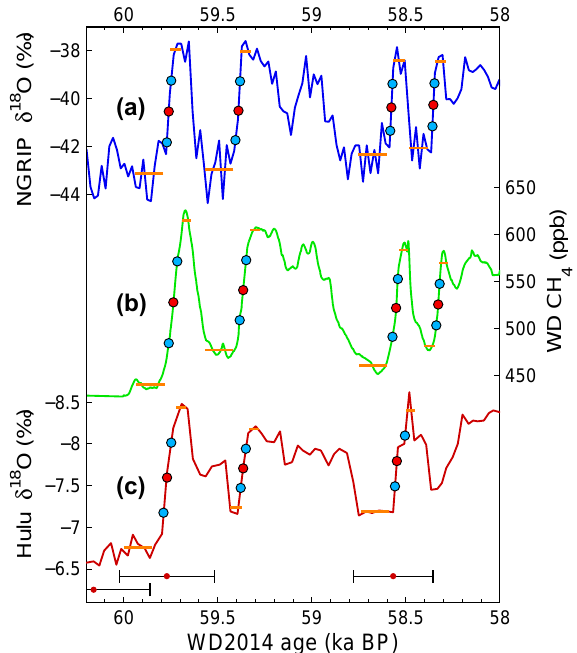
Figure 6. Determining the midpoint for the abrupt warming phases of (from oldest to youngest) DO 17.2, 17.1, 16.2, and 16.1 in (a) NGRIP δ 18 O (on 1 . 0063 × GICC05), (b) WD CH 4 (continuous data, on WD2014), and (c) Hulu δ 18 O with U / Th ages beneath the time series (red dots with error bars). Red dots give the midpoint (50%) of the DO transition; the blue dots give the 25 and 75% marks in the DO transitions. The DO transition at 58.35ka was not used in Hulu, where it is much more gradual than in the other records (pos- sibly because calcite sampling was not perfectly perpendicular to the stalagmite isochrones, or because growth rates were variable in between the U / Th